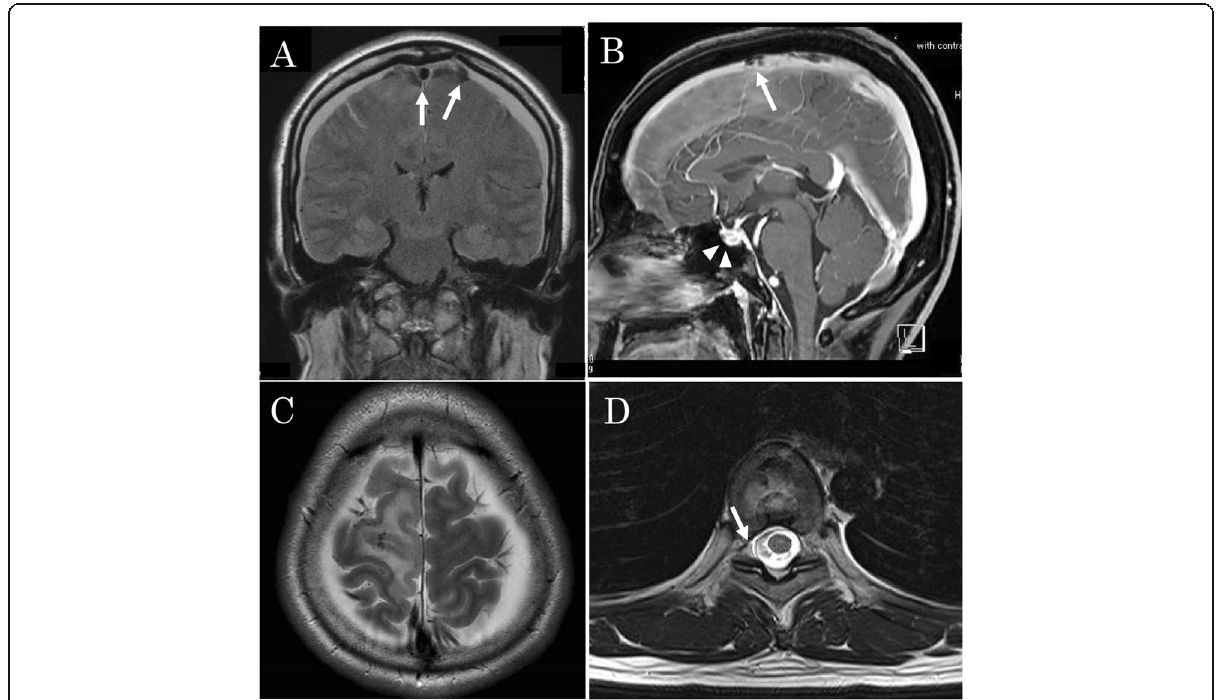
Fig. 2 a Coronal T1-weighted gadolinium-enhanced MRI showing diffuse pachymeningeal enhancement and cortical vein thrombosis (arrows). b Sagittal T1-weighted MRI showing enlargement of the pituitary gland (arrow head) and cortical vein thrombosis (arrow). c Axial cranial MRI showing cerebral edema. d Spinal MRI showing anterior epidural fluid collection at the level of the T4 – T10 spinal canal (arrow). MRI,